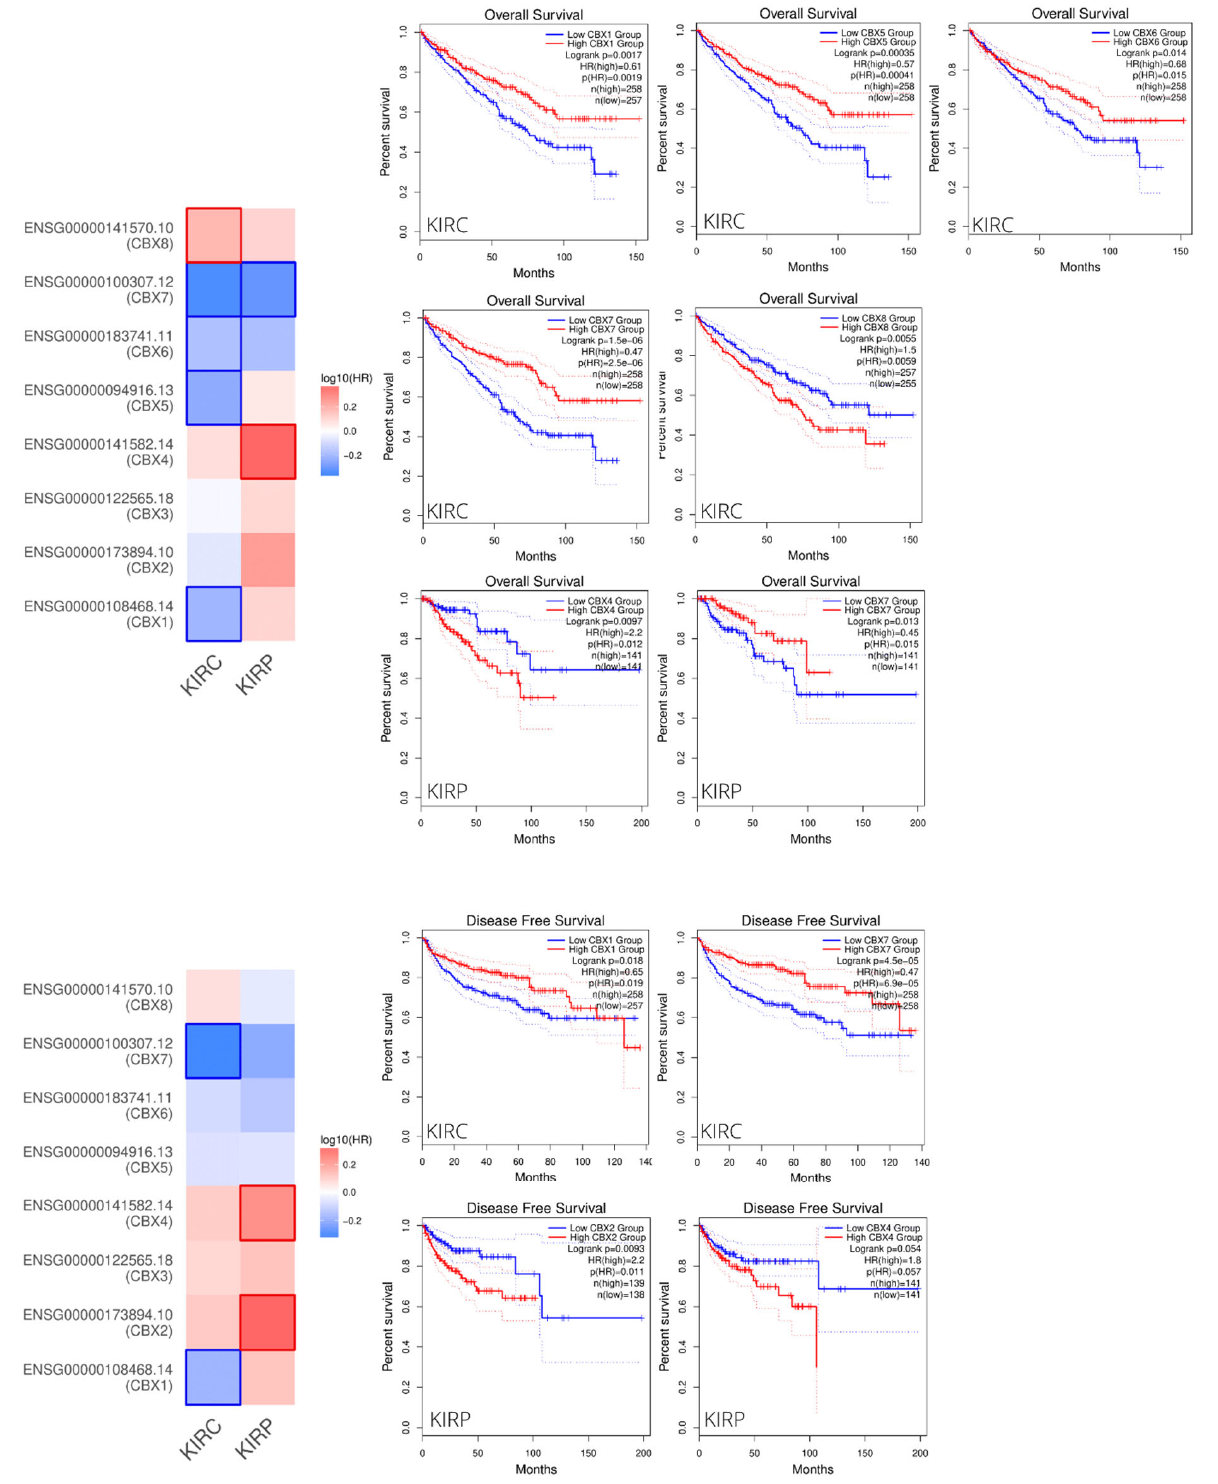
Figure 4. The prognostic impact of CBXs expression level is based on the survival heat map and Kaplan–Meyer curve. The heat maps show the hazard ratios in a logarithmic scale (log10) for different CBX genes. The red and blue blocks denote higher and lower risks, respectively. The rectangles with frames mean the significant unfavorable and favorable results in prognostic analyses ( p < 0.05). The Kaplan–Meyer curves based on RCC subtypes have been reported only for CBXs with significant prognostic impact.